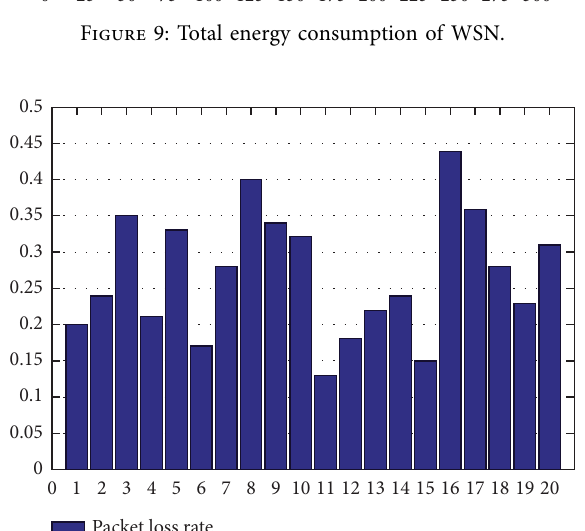
Figure 10: Histogram of node packet loss rate collected.